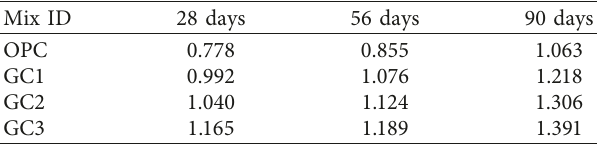
Figure 12: Water absorption percentage as a function of curing period for different concrete mixes. Table 8: Water absorption percentage for different concrete mixes at different curing periods.